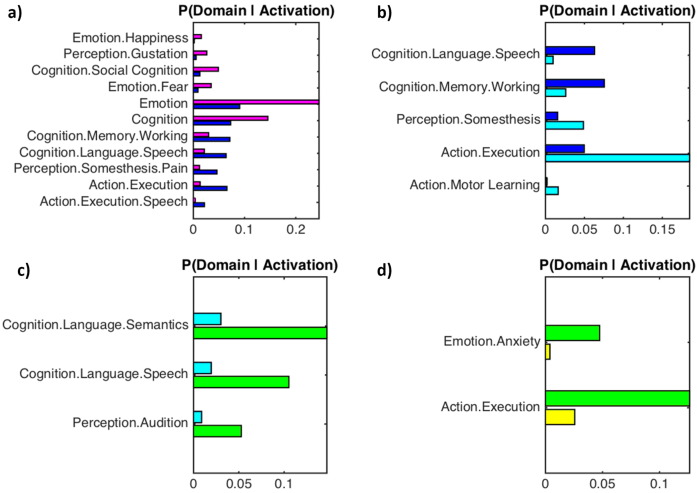
Functional characterization of cingulate clusters: bar plots show the reverse inference Bayesian probabilities (i.e. the likelihood of a behavioural domain given the location of the activation cluster) for behavioural domains associated with each cluster. Behavioural domains are contrasted with adjacent clusters and corrected for multiple comparisons (FDR, p < 0.05). Thus a larger bar indicates a behavioural domain is more likely to elicit activity in a specific cluster. The colour of each bar corresponds to the colour code established in Fig. 2. A) ACC (magenta) compared to aMCC (blue). B) aMCC (blue) compared to pMCC (cyan). C) pMCC (cyan) compared to dPCC (green). D) dPCC (green) compared to vPCC (yellow). (For interpretation of the references to colour in this figure legend, the reader is referred to the web version of this article.)